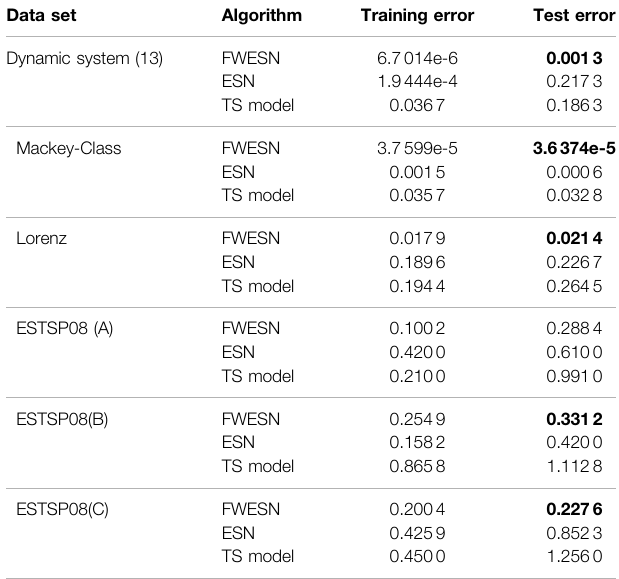
TABLE 1 | Experiment results for FWESN, ESN, and TS model.